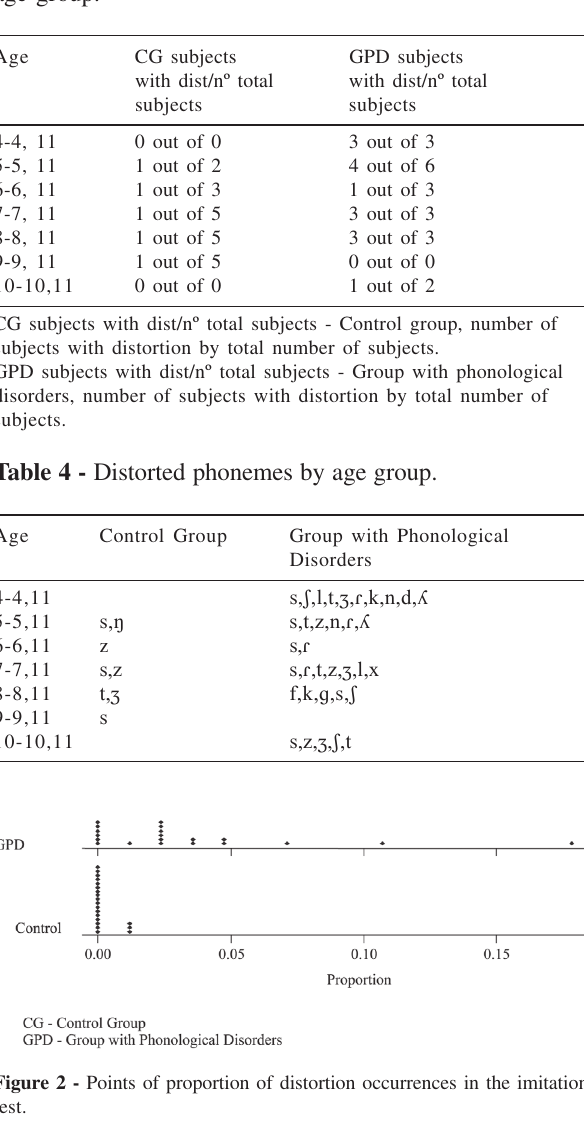
Table 3 - Number of subjects who presented distortions by age group.